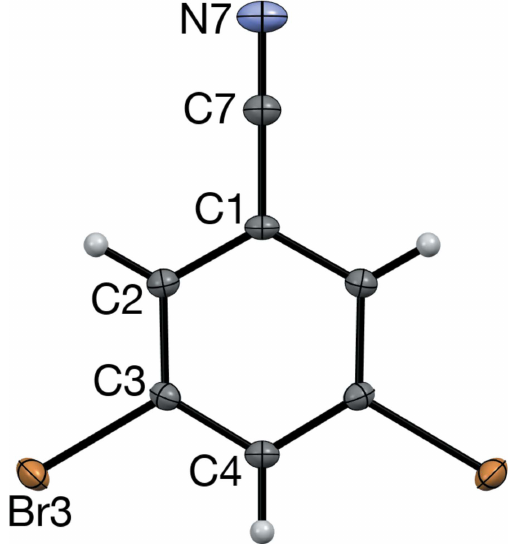
Figure 1 The molecular structure of (I), showing the atomic numbering and displacement ellipsoids at the 50% probability level. Unlabelled atoms (cid:6) y , z ) symmetry operation. are related by the ( x , 1 2